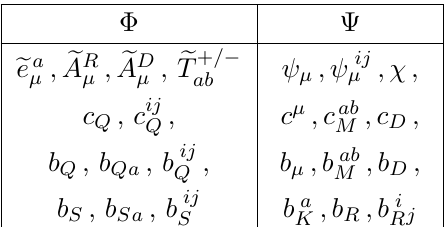
Table 4 . The elementary variables (47 bosons + 47 fermions) in the cohomological representation of the Weyl multiplet (cid:12)elds and ghosts. Here e T + = (cid:0) depending on the spacetime point as explained around